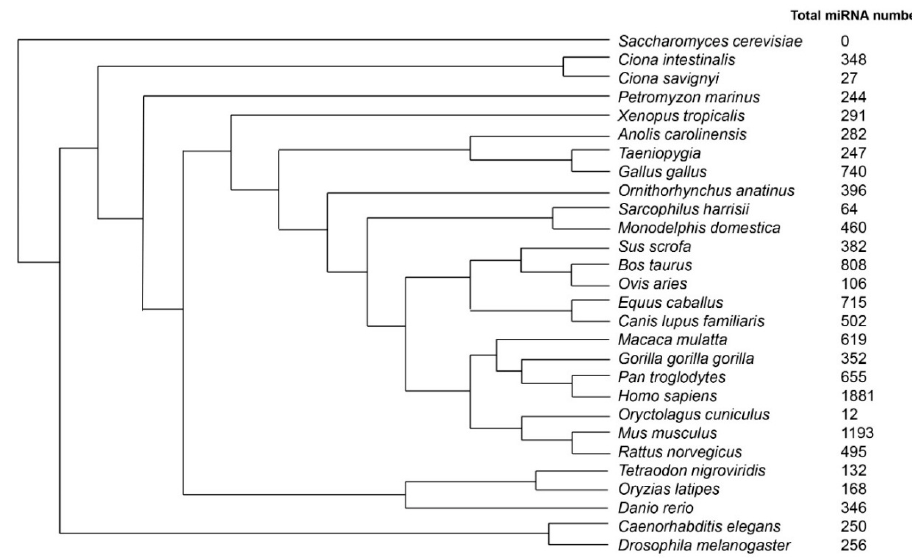
Figure 1. Summary of the total number of miRNA [14] identified in different species obtained from the latest version of miRBase v 21 database. The phylogenetic tree is generated according to the species tree obtained from Ensembl website [15].